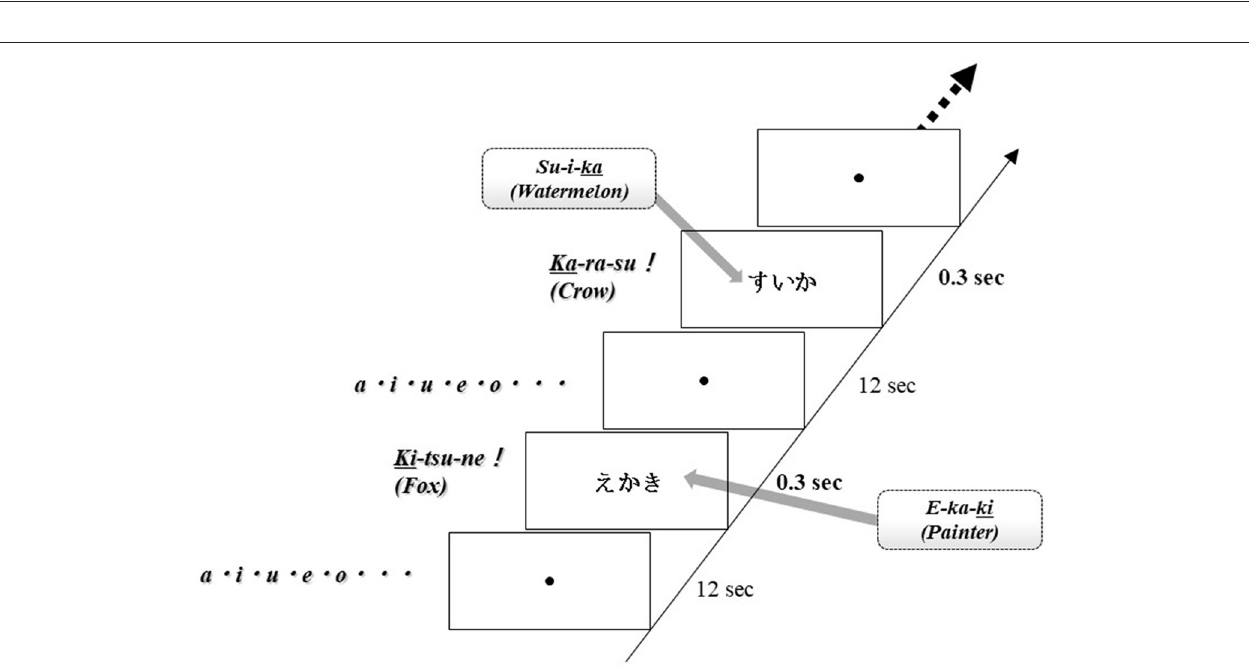
p = 0.0050; left ch.7: 256.00, p = 0.0105; left ch.9: U = 175.00, p = 0.0001; left ch.10: U = 227.00, p = 0.0026; left ch.11: U = 217.00, p = 0.0016; left ch.12: U = 216.00, p = 0.0024; left ch.13: U = 244.00, p = 0.0061; left ch.18: U = 264.00, p = 0.0149; left ch.22: U = 239.00, p = 0.0077; right ch.8: U = 209.00, p = 0.0010; and right ch.11 U = 208.00, p = 0.0016). Waveforms are shown in Figure 3 .